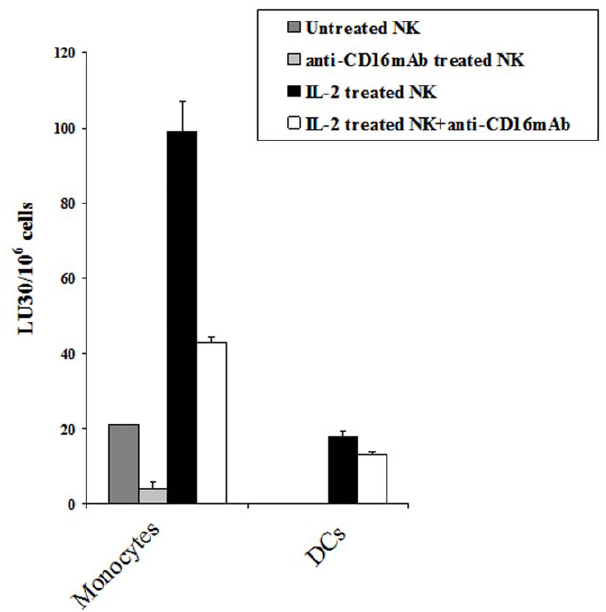
Figure 7. Monocytes are significantly more sensitive to NK cell mediated cytotoxicity than DCs. NK cells (1 6 10 6 /ml) were left untreated or treated with IL-2 (1000 units/ml), or anti-CD16 mAb (3 m g/ ml) or a combination of IL-2 (1000 units/ml) and anti-CD16 mAb (3 m g/ ml) for 12-24 hours before they were added to 51 Cr labeled autologous monocytes or 51 Cr labeled autologous DCs, and NK cell cytotoxicities were determined using a standard 4 hour 51 Cr release assay and the lytic units 30/10 6 cells were determined using inverse number of NK cells required to lyse 30% of the monocytes or DCs 6 100. One of four representative experiments is shown in this figure.